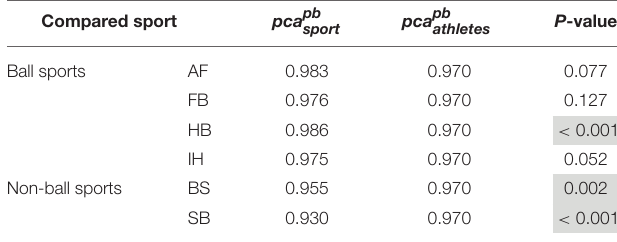
TABLE 2A | Single sport vs. whole athlete group —horizontal canals. TABLE 2B | Single sport vs. whole athlete group —vertical